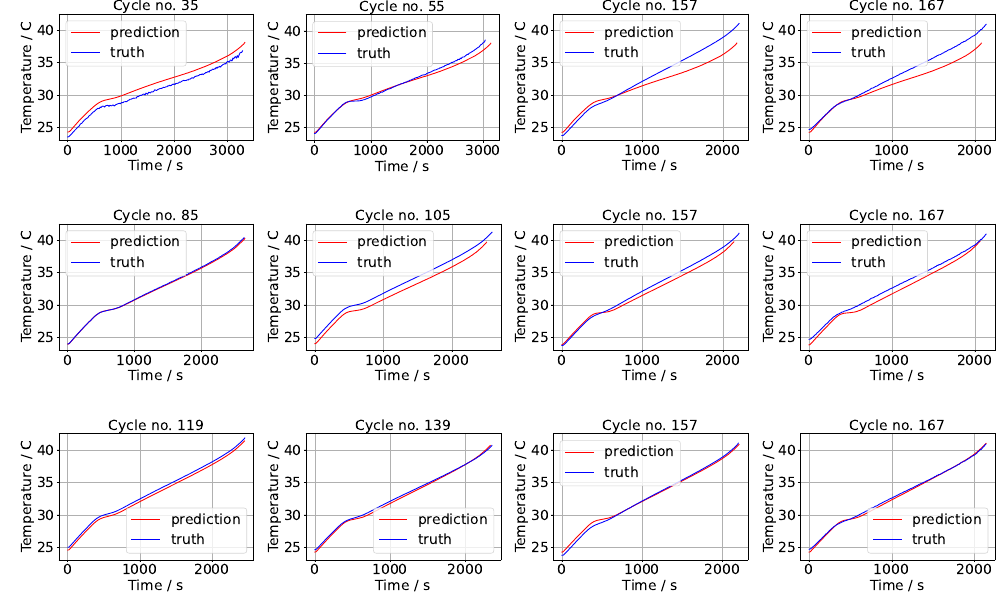
Figure 5. Temperature results for the data set B0006 for different numbers of training points. From the top row to the bottom row, 20%, 50% and 70% of the data is used.